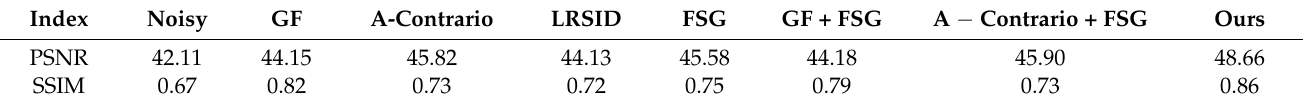
MSE means the mean square error between original image and processed